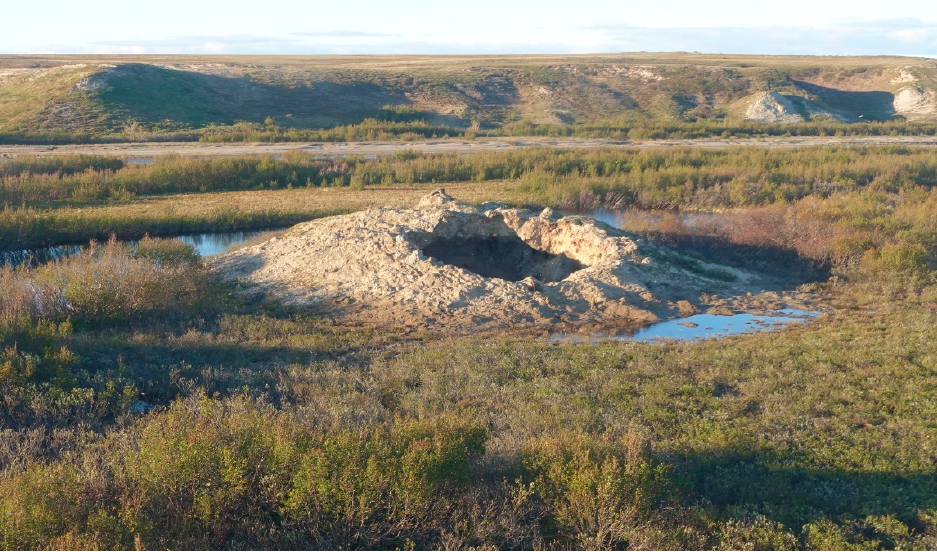
Figure 5. Gas-emission crater in the floodplain of the Erkuta–Yakha River (Yamal Peninsula), summer 2017. Photograph by A. Sinitsky (number on the map: 8).